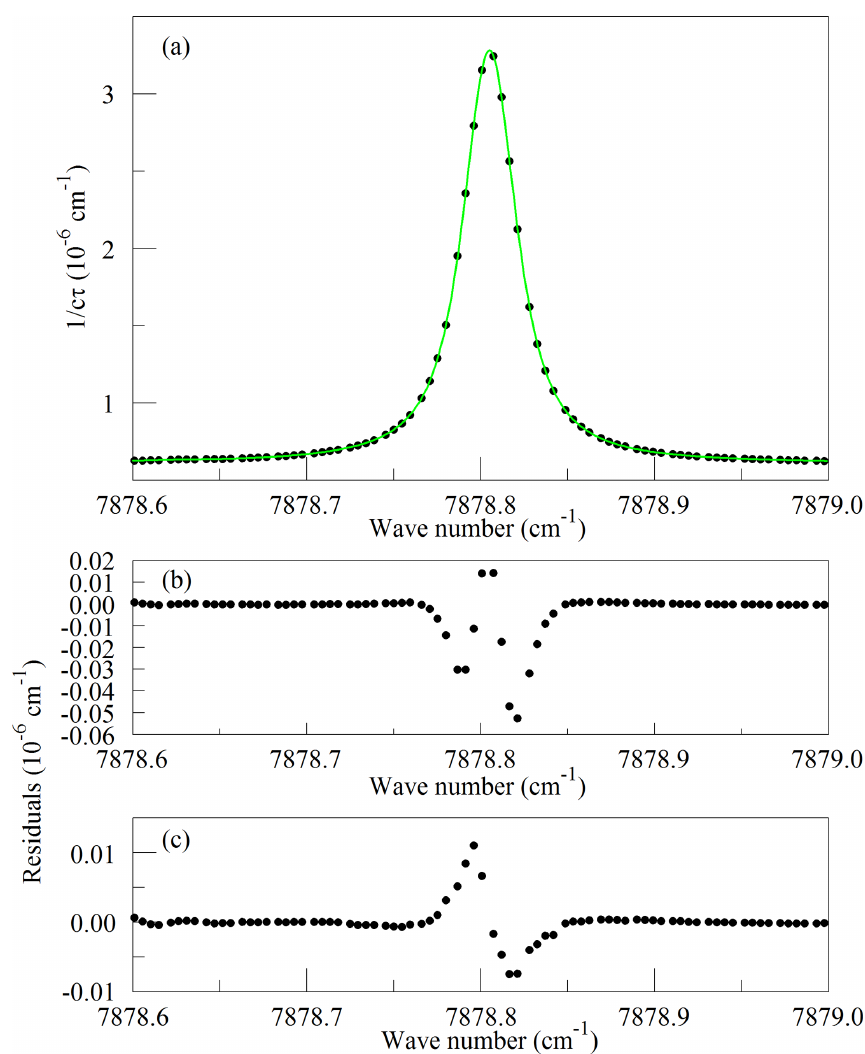
Figure 1. Panel (a) shows the raw data (points) and the best-fit Galatry function (solid line); residuals of the Voigt fit are shown in panel (b) ; and residuals of the Galatry fit are shown in panel (c)